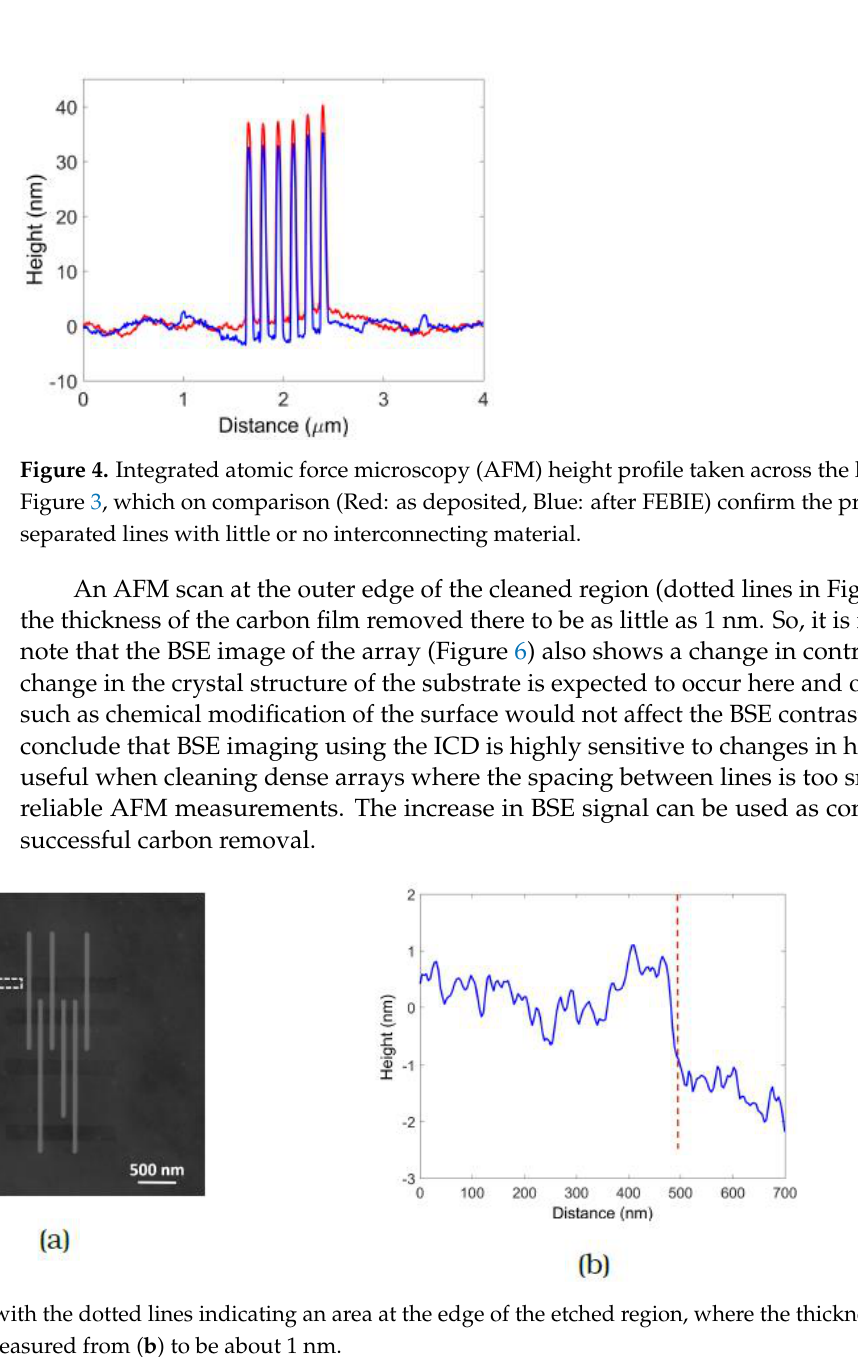
Figure 3. ( a ) SE image of array of carbon FEBID lines after large area cleaning. The red dashed rectangle indicates a typical etched region. Four regions containing lines of spacing 150 nm, 300 nm and 450 nm were etched for a time of 7 s each. ( b ) Integrated intensity plot of topmost region before focused electron beam-induced etching (FEBIE) (red) and after FEBIE (black). The increase in SE signal observed in between the lines demonstrates the removal of carbon and the extent of this region corresponds with the exposed area.